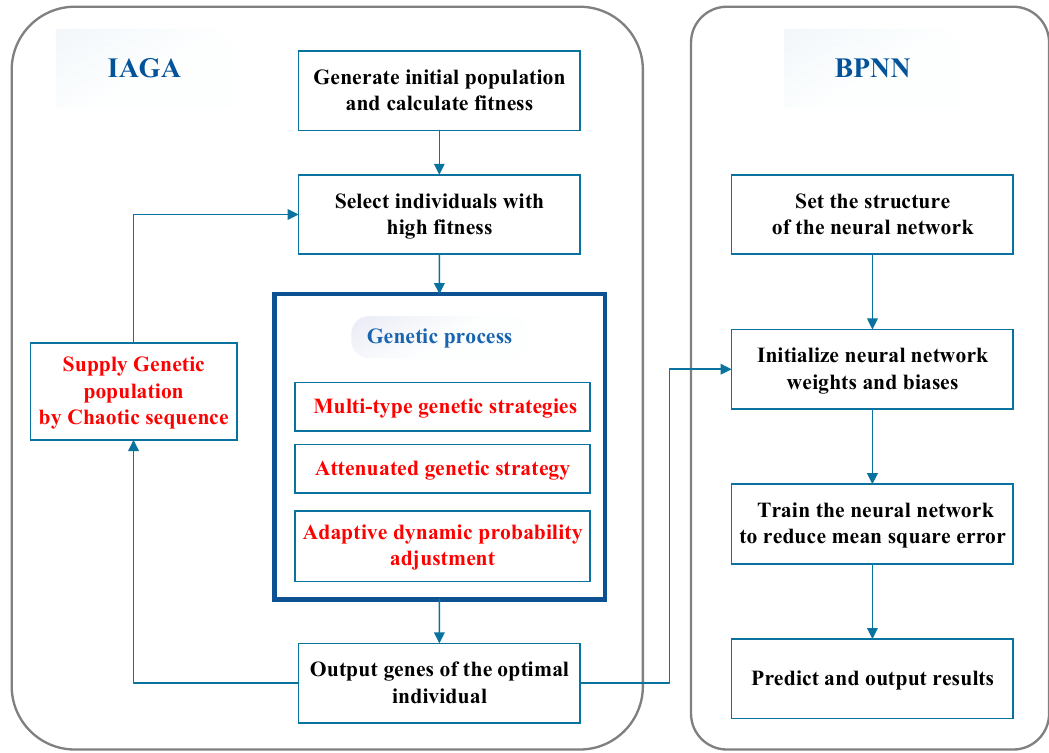
Figure 4. Basic execution process of the improved genetic algorithm coupling a back-propagation neural network (IGA-BPNN) model and 4 types of genetic improvement strategies.